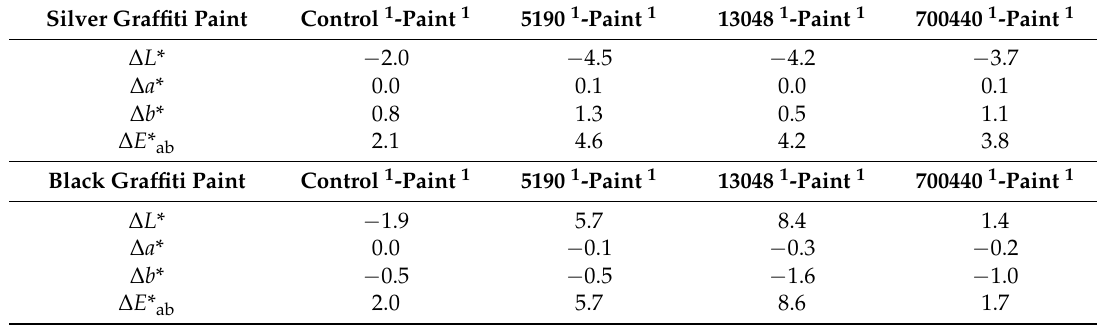
Figure 6. Micrograph of particles of powdered graffiti surrounded by biofilm (white arrows). Table 1. Partial colour differences ( ∆ L *, ∆ a * and ∆ b *, CIELAB units) and total colour difference ( ∆ E * ab , CIELAB units) between the powdered